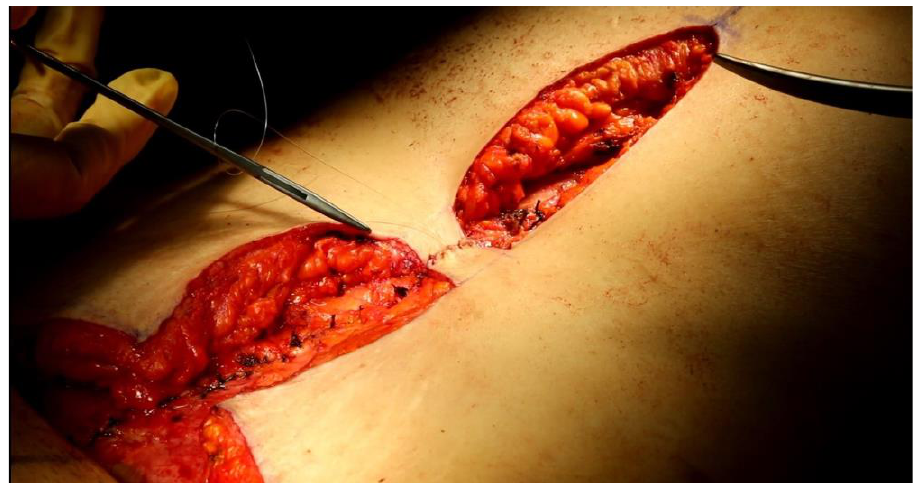
Figure 3. The two rectangular flaps are sutured to each other along the midline.